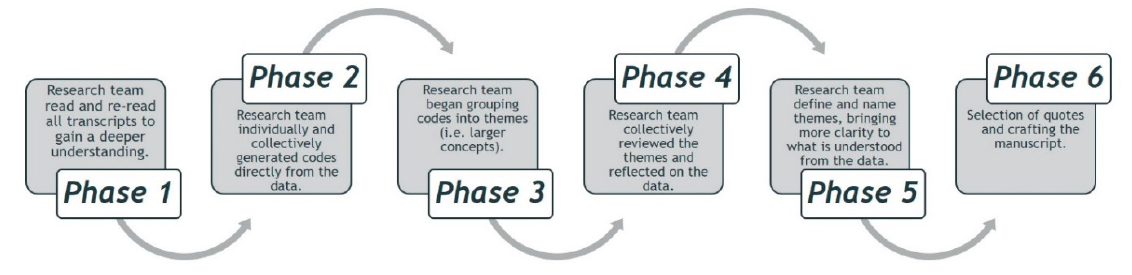
Figure 1. Phases of data analysis.